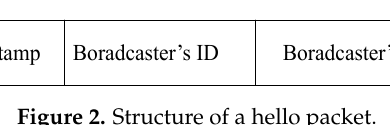
Figure 2. Structure of a hello packet.